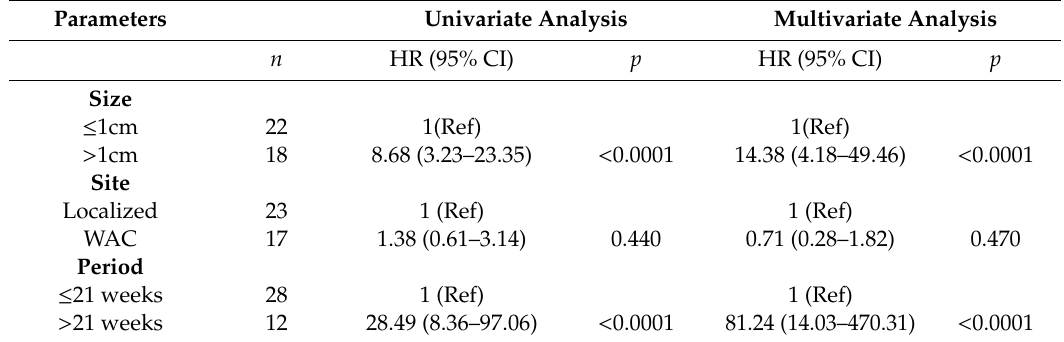
Table 3. Association between baseline characteristics and progression-free survival.